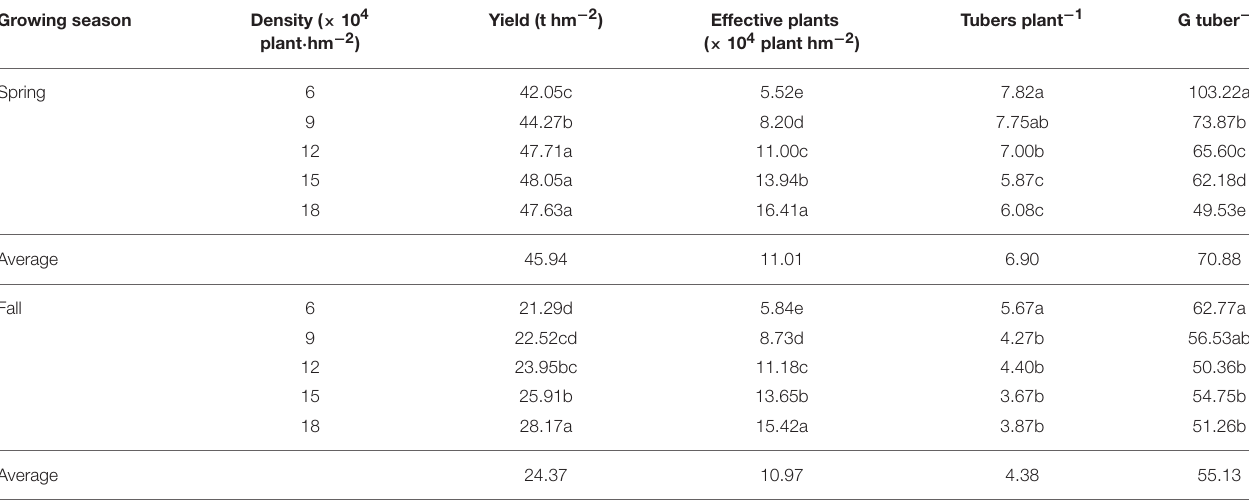
TABLE 3 | Yield and yield components under different plant densities in the two growing seasons.